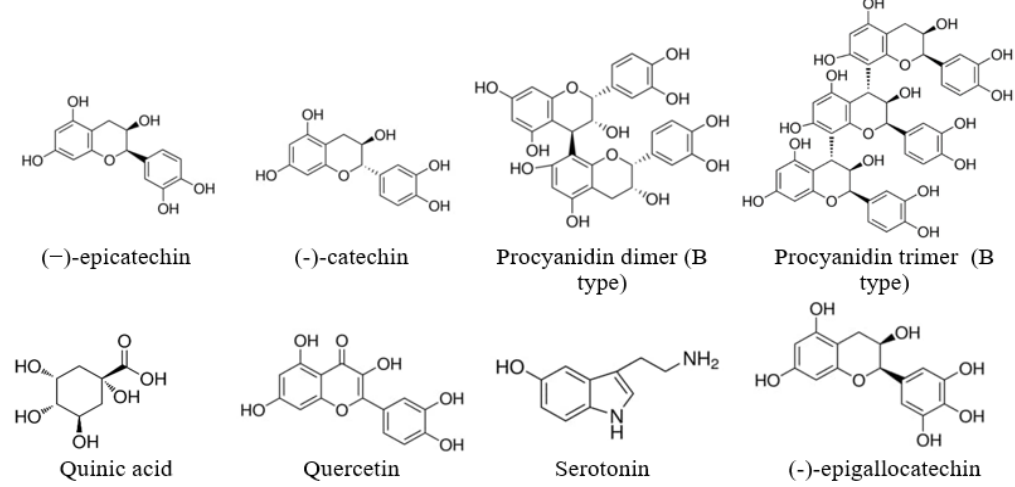
Figure 2. Some of the identified components of the extracts.